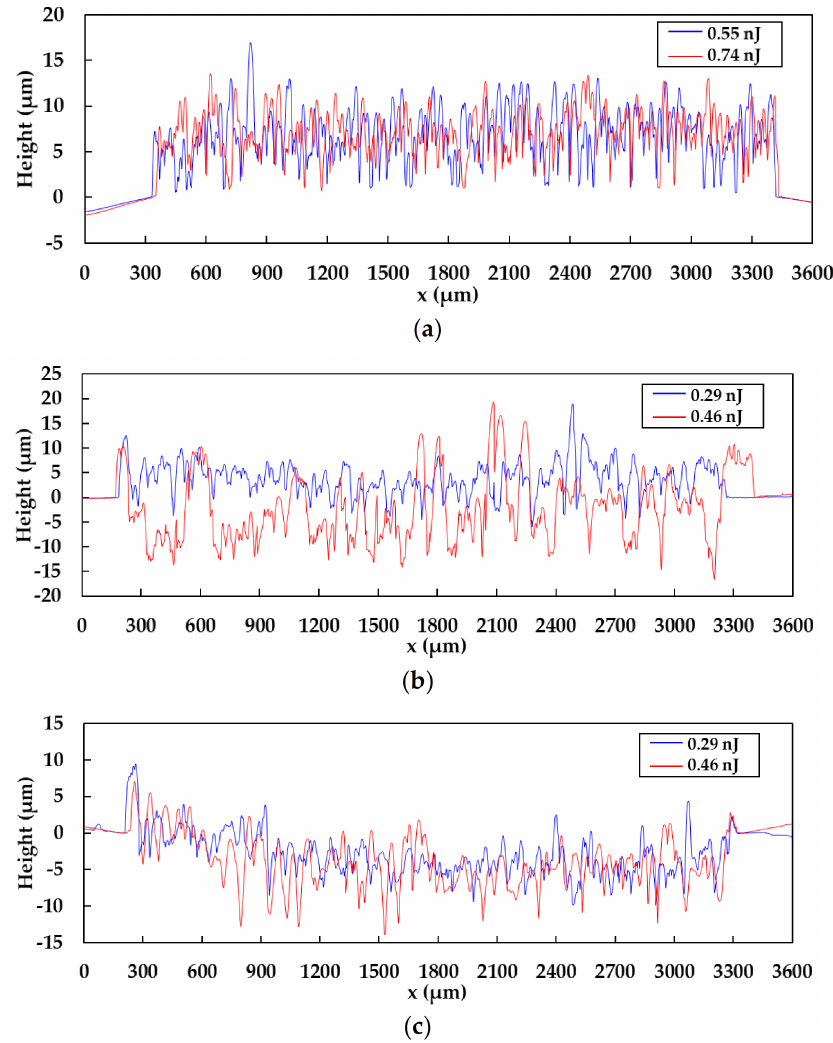
Figure 8. Cross-sectional profiles of the patterns fabricated at a pulse energy of ( a ) 0.55 and 0.74 nJ on glass substrates, and at a pulse energy of 0.29 and 0.46 nJ on ( b ) PEN and ( c ) PET substrates.